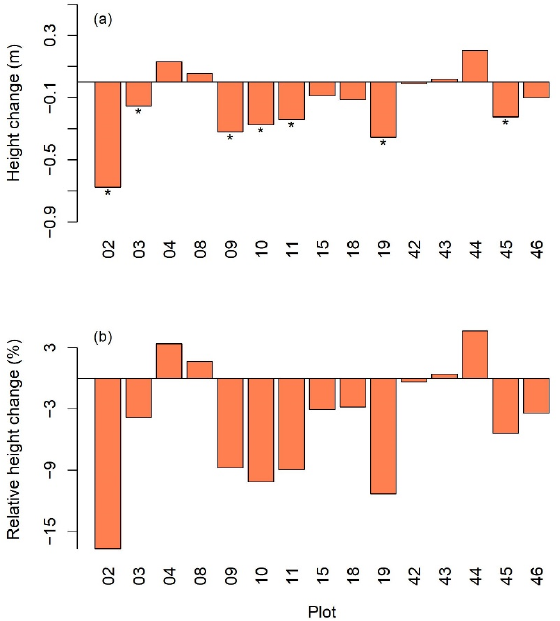
Figure 3. ( a ) Mean changes in stem height in the 15 plots. The “*” under the bar indicates significant decrease at α = 0.05; ( b ) relative mean height